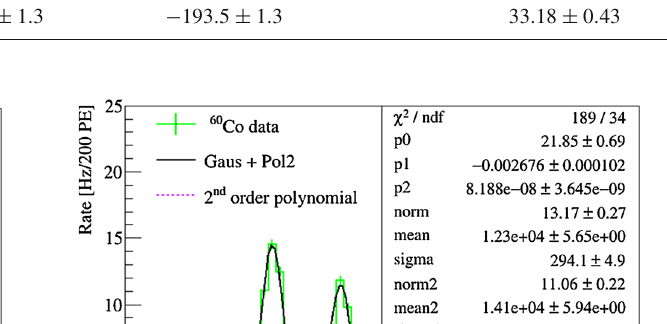
Table 1 Summary of the single-PE response for the top and bottom PMTs. Top and bottom rows for each PMT correspond to measurements before and after the energy calibration, respectively